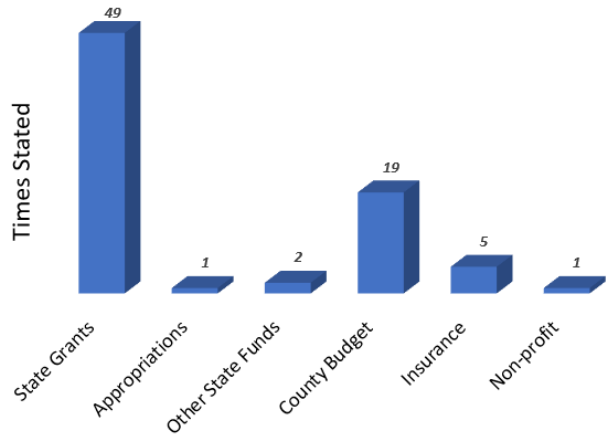
Figure 19. Funding terms used during